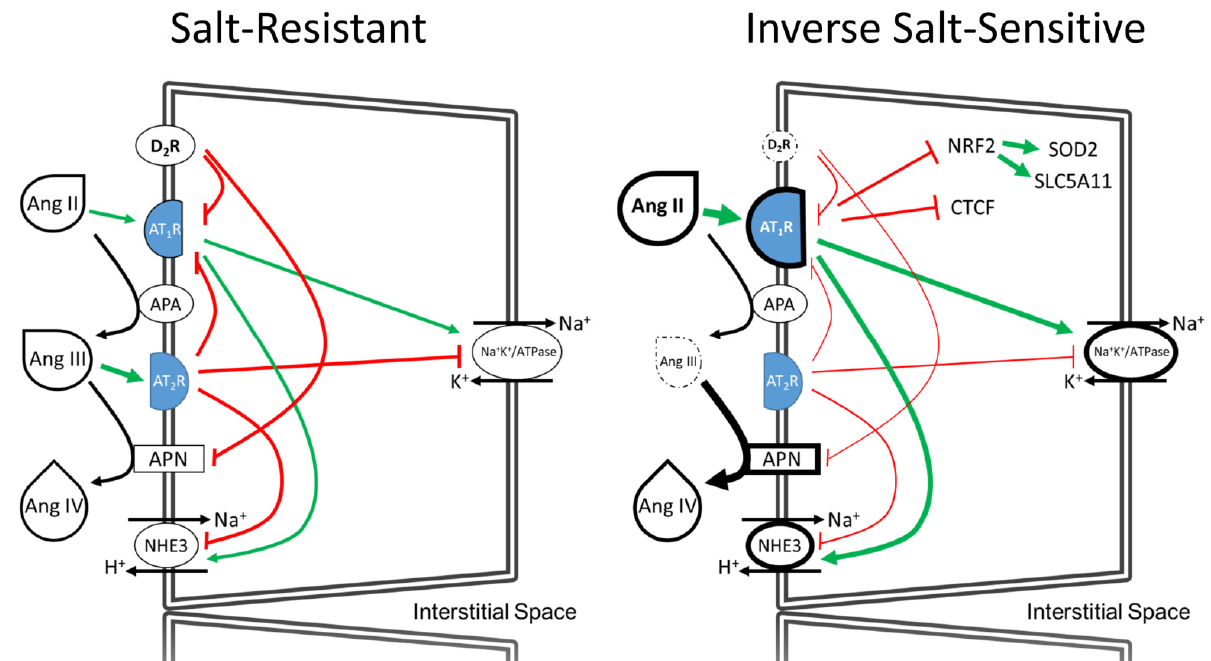
Figure 9. A model comparing SR and ISS under low salt condition. In low salt conditions juxtaglomerular cells increase renin and hepatocytes produce more angiotensinogen, delivering increased angiotensin I (Ang I) to the renal proximal tubule where angiotensin converting enzyme, ACE1, on the surface of the proximal tubule cell converts Ang I to Ang II. In ISS, angiotensin type 1 receptor (AT 1 R) is sensitized due to the decreased negative regulation by D 2 R. Increased AT 1 R signaling leads to increase sodium transport. ISS in low salt increases the expression of APN even more, causing a reduction of Ang III, the preferred agonist of AT 2 R, and further sensitizing the AT 1 R by reducing the negative regulation of the AT 2 R on AT 1 R signaling. A feed-forward system is then established by increased AT 1 R signaling leading to increased renin, angiotensinogen, ACE1, and lowering APA, in order to raise Ang II and lower Ang III peptide levels. The increased AT 1 R signaling lowers NRF2 and SOD2 levels leading to increased free radical damage to the cell, as well as decreased positive epigenetic regulation of DRD2 via CTCF. Green lines represent positive cell signaling pathways with thicker green lines representing enhanced positive signaling; Red lines represent negative cell signaling pathways and thinner red lines representing decreased negative regulation; Dotted circles around proteins represent decreased protein expression.